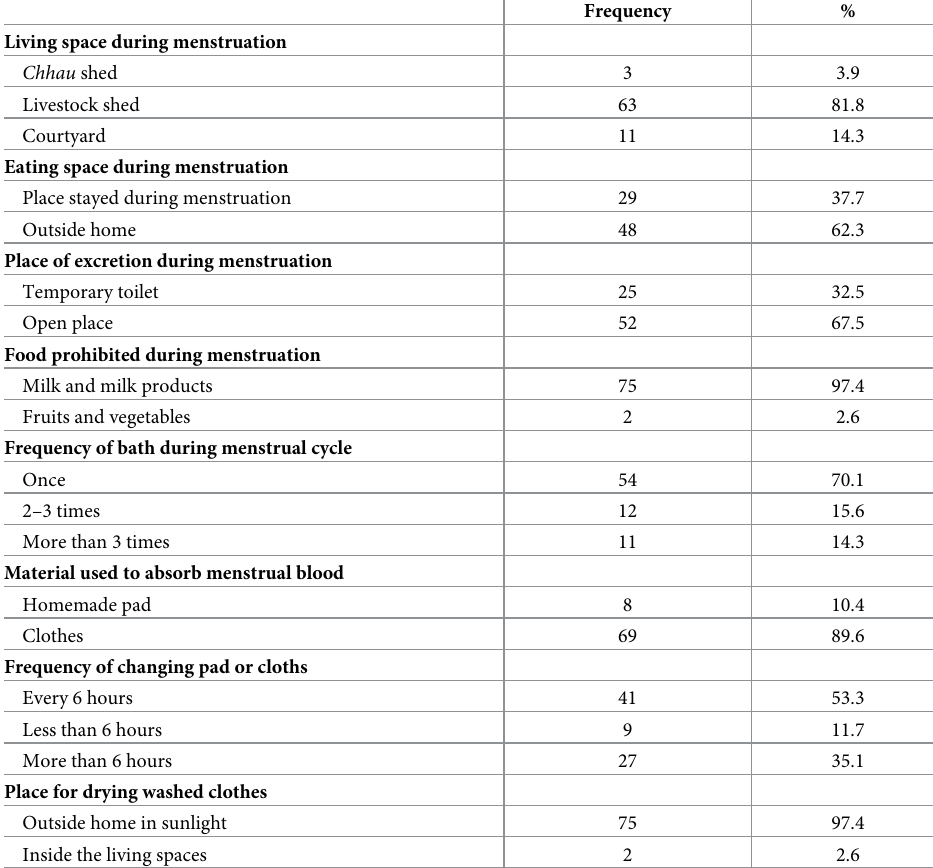
Table 2. Characteristics of the practice of Chhaupadi among study participants (N =